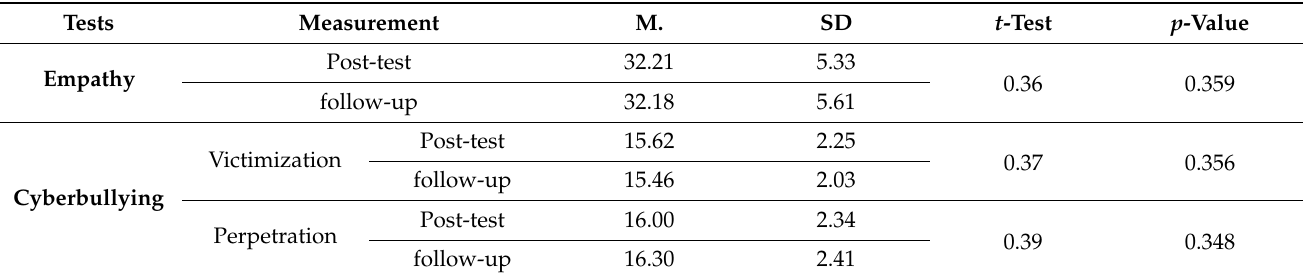
Table 4. Mean scores of adolescents in the experimental group on the post- and follow-up measure- ment on the TEQ and BCS-A (N =